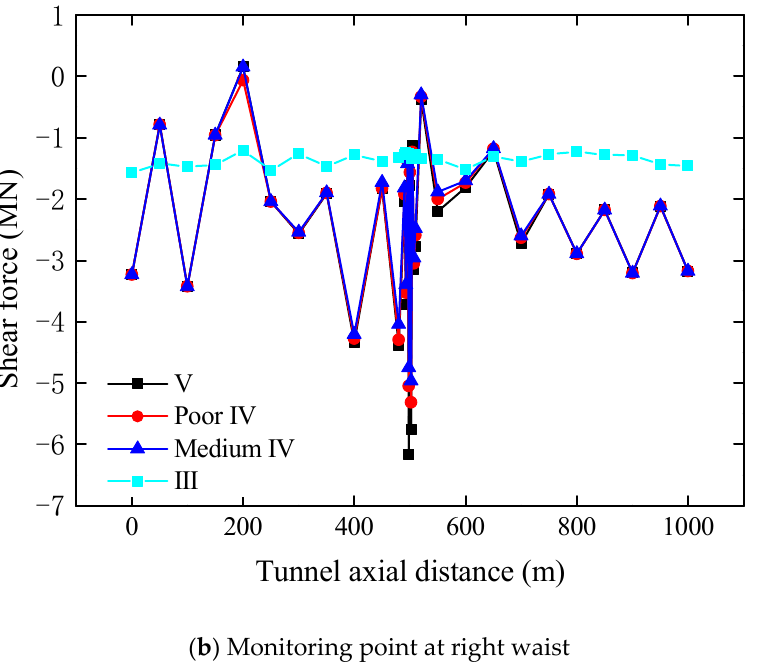
Figure 14. Shear force of the lining monitoring points of the tunnel passing through adverse geological structure zone with different lithologies.